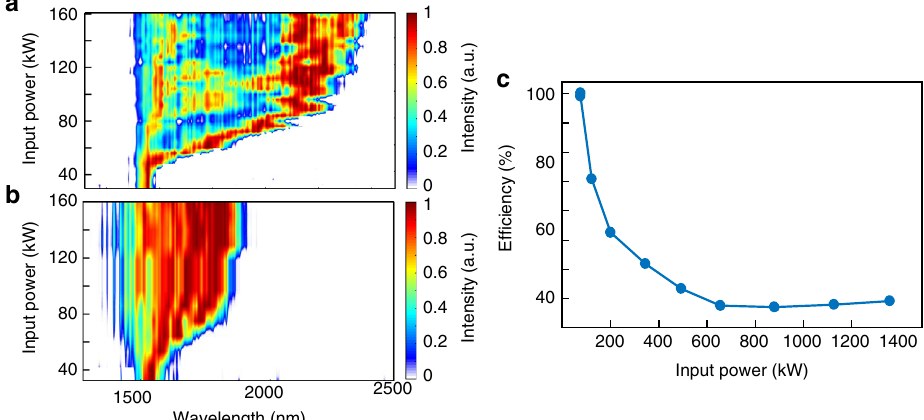
Fig. 6 Experimental comparison of soliton red-shifting in a tapered and a uniform multimode fi ber. a The output spectrum after a 3-m tapered multimode fi ber with a core radius decreasing from 30 to 10 µ m. As the input power level increases, the soliton experiences a signi fi cant red-shifting that extends up to 2300 nm. b The recorded output spectrum from a 3-m uniform graded-index multimode fi ber having a core radius of 25 µ m. In this regime, the solitons experience a subdued red-shifting up to 1900 nm. c The transmission ef fi ciency curve as obtained by comparing the fi ber output power before and after the tapered segment. As the input power level increases, the ef fi ciency drops. In all cases, 100-fs pulses at 1550 nm are